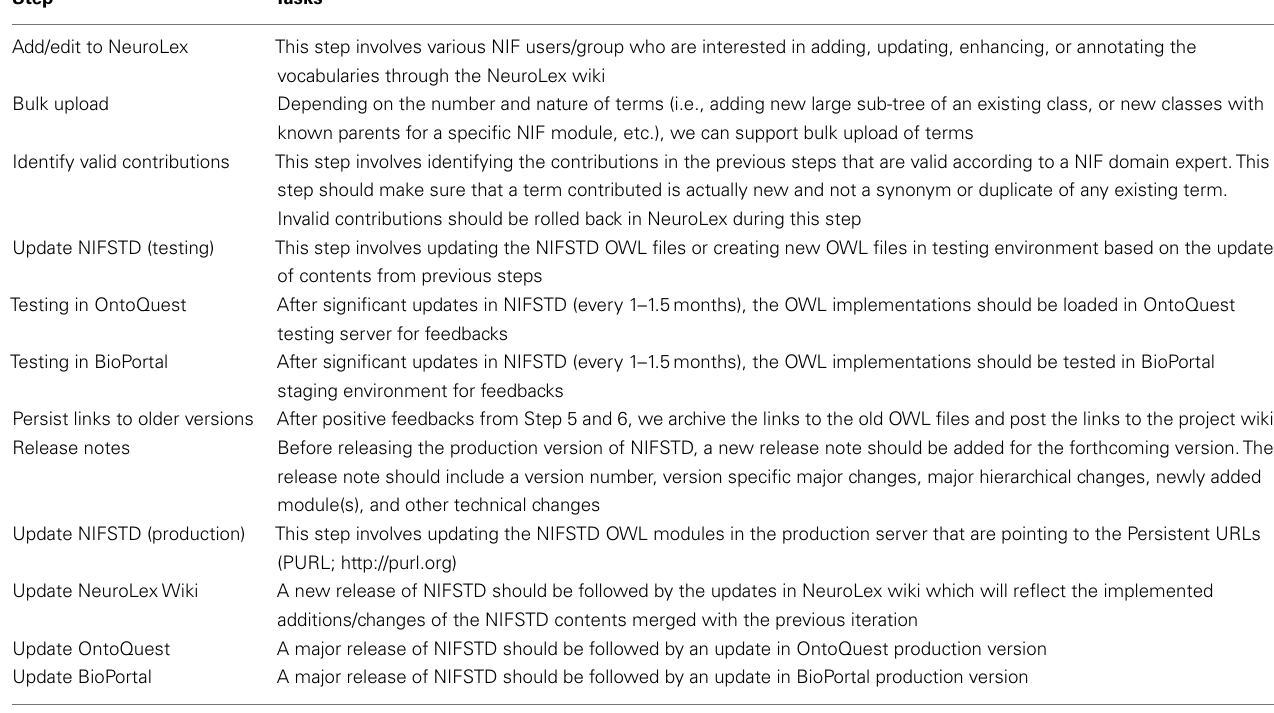
Table 2 |The steps and tasks involved in NIFSTD/NeuroLex curation